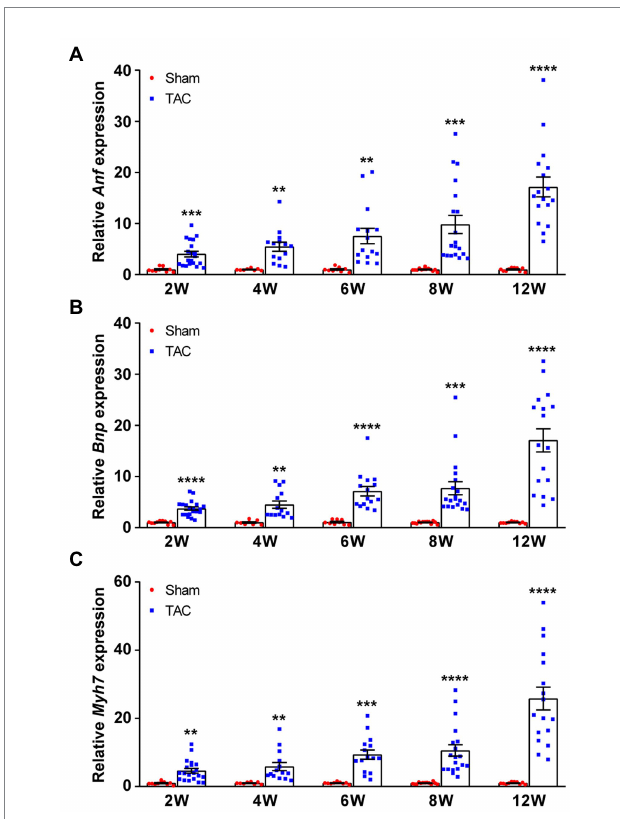
FIGURE 8 Expression of fetal genes during TAC-induced time-series cardiac remodeling. Expression of the Anf (A) , Bnp (B) , and Myh7 (C) in mouse hearts was quantified by qPCR at various times upon surgery. n = 8~20. Unpaired t -test for two-group comparisons, ** p < 0.01, *** p < 0.001, **** p < 0.0001 vs. the corresponding